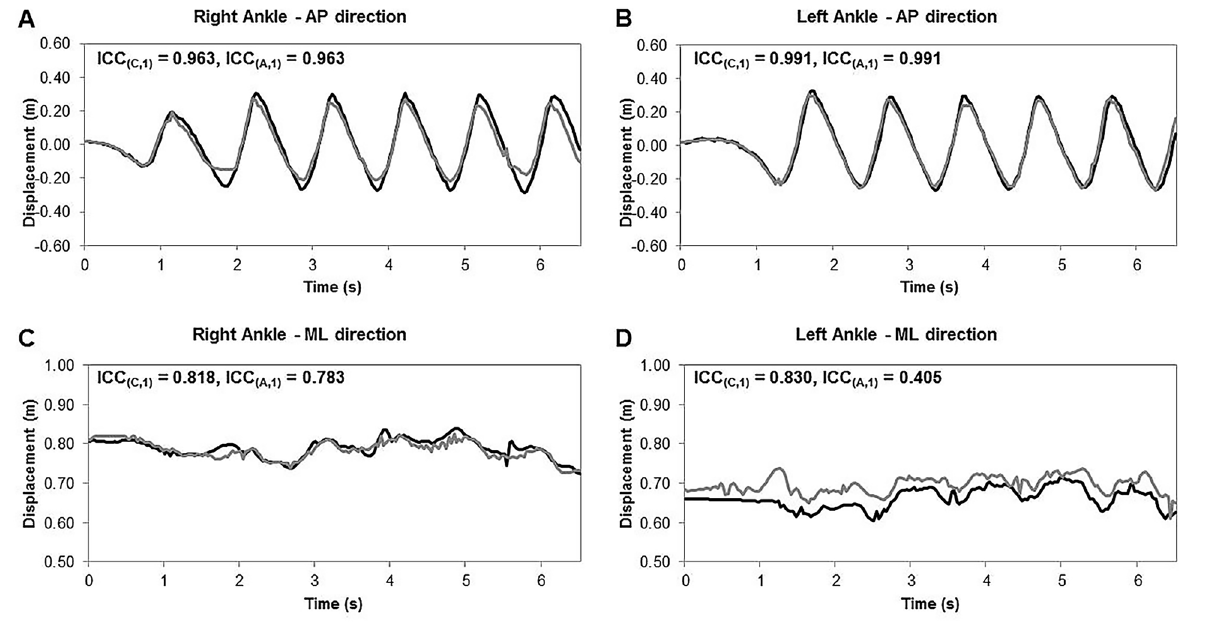
Fig 5. Representative ankle time series of the multi-Kinect v2 set-up and the Optotrak system. Multi-Kinect v2 (gray lines) and Optotrak (black lines) time series of the right (panels A and C) and left (panels B and D) ankle in the AP (detrended) and ML direction for a part of a CWS trial, including between- systems agreement assessed with the intraclass correlation coefficient for consistency (ICC (C,1) ) and absolute agreement (ICC (A,1)